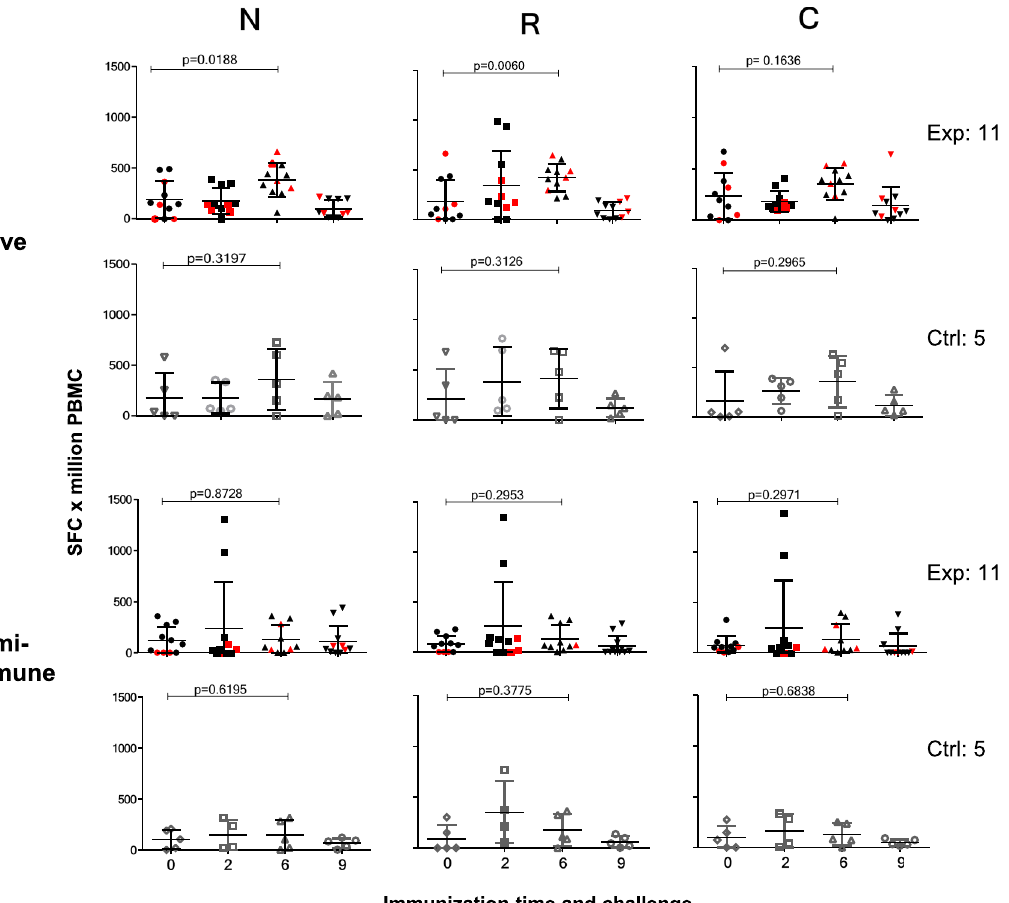
Fig. 4 Speci fi c induction of IFN- γ by Pv CS-LSP in naive and semi-immune groups. Single-cell interferon gamma (IFN- γ ) ex vivo production by fresh peripheral blood mononuclear cells (PBMC) from naive ( n = 17) and semi-immune ( n = 18) volunteers collected before immunization (0, 2, 6 months) and CHMI (month 9). Values are expressed as mean of IFN- γ (spot-forming cells) sfc/log10 6 in response to 40 h of in vitro stimulation with each Pv CS protein fragment (N, R, C). Cells produced IFN- γ upon stimulation with the different fragments in an unstable manner throughout the study phases but with signi fi cant differences between naive and semi-immune volunteers (N, p = 0.046; R, p = 0.0013; C, p = 0.005. Only peptides N ( p = 0.0188) and R ( p = 0.0060) displayed signi fi cant differentes between fi rst and third immunization. Neither naive (N, p = 0.67; C, p = 0.94; R, p = 0.15) nor the semi- immune (N, p = 0.76; C, p = 0.71; R, p = 0.48) IFN- γ levels were associated with parasitemia. Red symbols denote sterilely protected volunteers. Source data are provided as a Source data fi